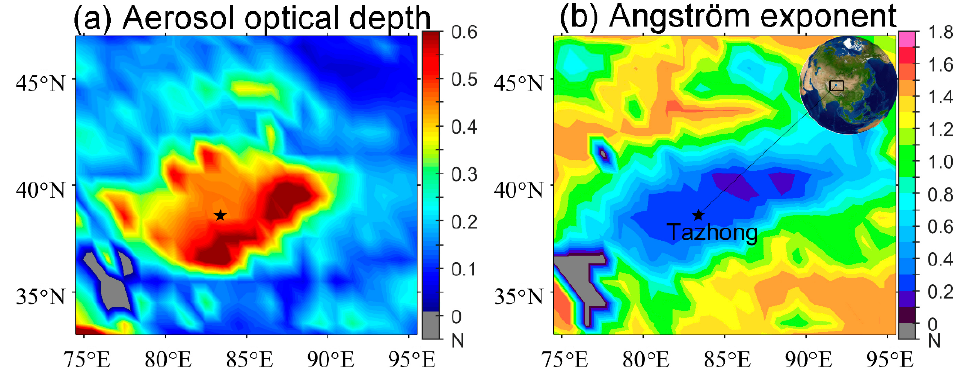
Figure 3. ( a ) AOD 550 and ( b ) AE 412–470 . Measured by MODIS from 2003 to 2020 in the Tazhong area during the summer. The X -axis indicates longitude, while the Y -axis represents latitude. The black arrow in ( b ) represents the Taklimakan Desert region on the world map. The black pentacle in the figure indicates the geographic location of the study site.